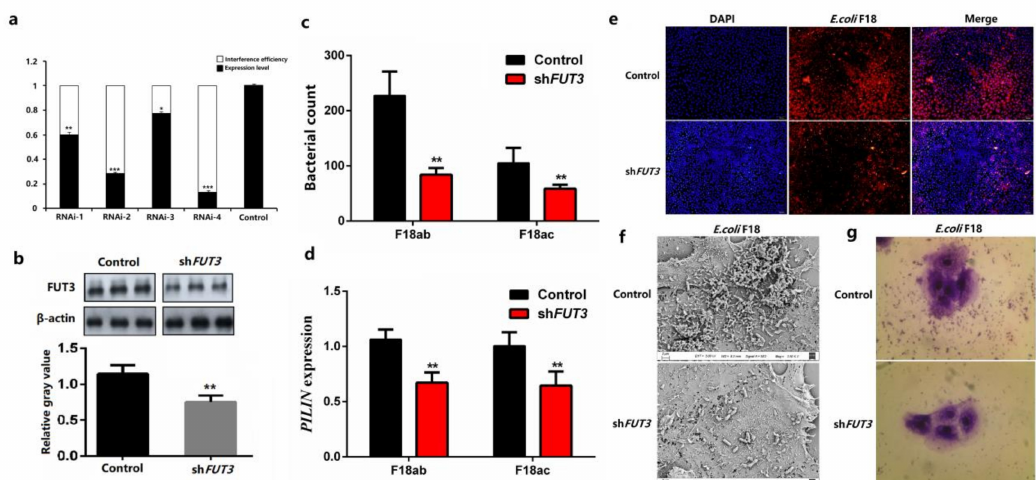
Figure 3. Knockdown of FUT3 enhances E. coli F18 resistance. ( a ) Interference efficiency evaluation of FUT3 in RNAi-n ( n = 1, 2, 3, 4) by qRT-PCR. ( b ) Interference efficiency of FUT3 for RNAi-4 was assessed by immunoblot validation. ( c,d ) Adhesion of the F18 fimbria to IPEC-J2 cells were evaluated via bacteria enumeration and relative quantification detection, results are represented as mean ± SEM, n = 3 biological replicates, ** p < 0.01. ( e ) Immunofluorescence assay. Blue fluorescence indicates nuclear staining via DAPI, red fluorescence indicates E. coli antibody. ( f ) Scanning electron microscopy (SEM) assay, cells were found under a scanning electron microscope (2500 × ). ( g ) Gram staining assay. An optical microscope (400 × ) was used to observe